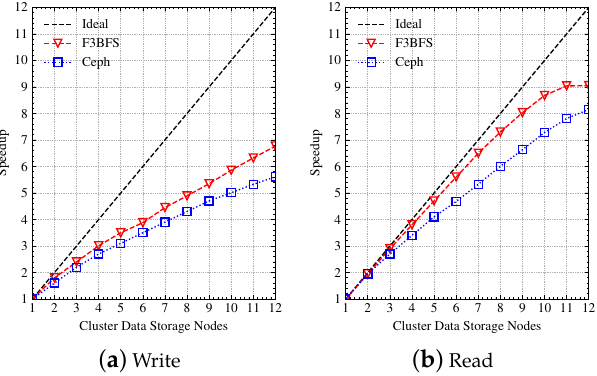
Figure 7. Data throughput speedups with different cluster